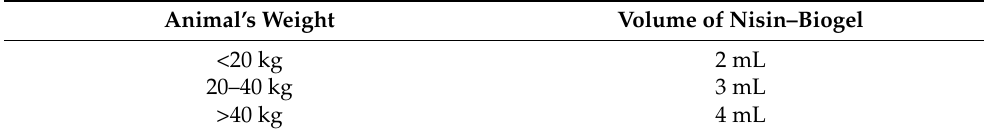
Table 1. Posology of the nisin–biogel (200 µ g/mL) according to the animal’s weight.